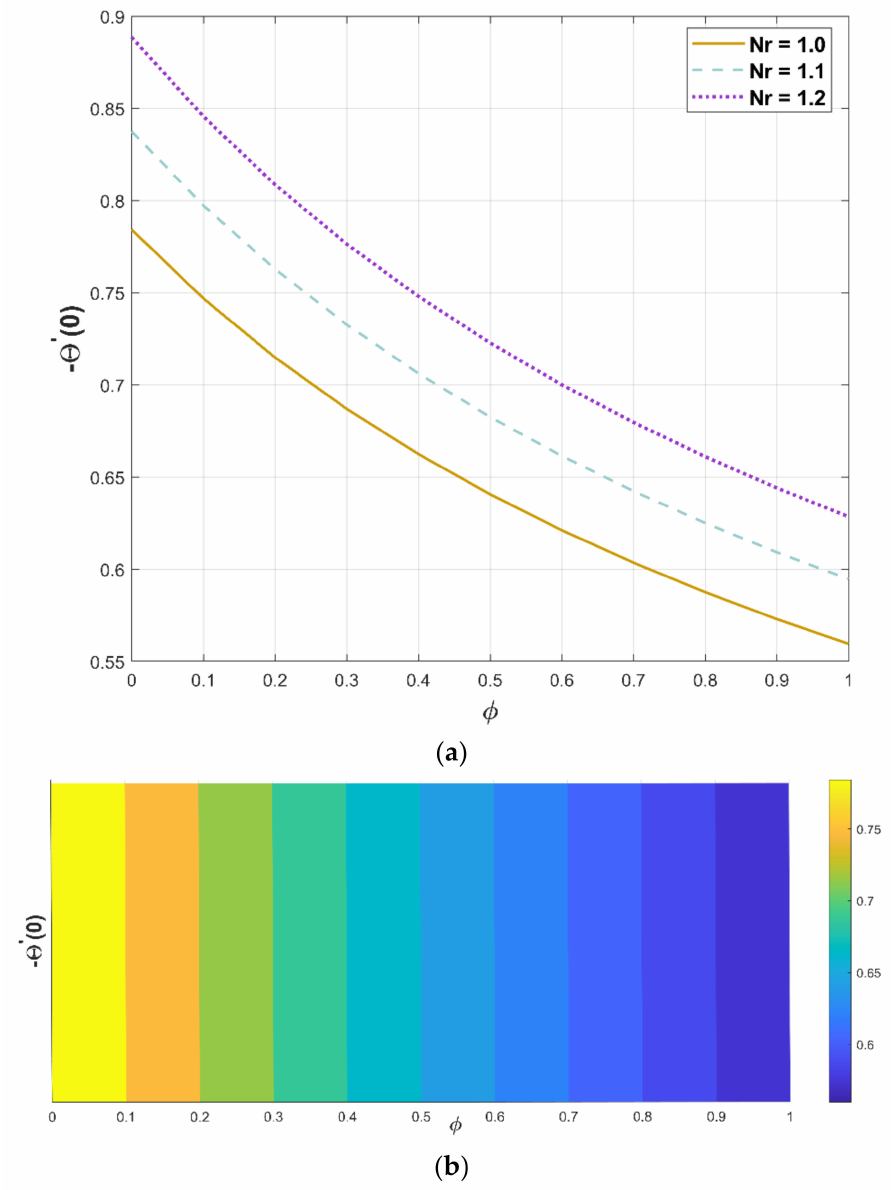
Figure 13. ( a , b ). Upshot of Nr and φ on − Θ (cid:48) ( 0 ) . For lower variability in R ∗ , it is found that the heat flux enhances. The fundamental d notion for using permeable fin is to enhance the efficacious surface area through which heat is convected to the nearby liquid. Even though the effectual thermal conductivity of the permeable fin weakens due to the discharge of solid substance, this decline is balanced by an expansion in surface area. As a consequence, increased porosities significantly augment the heat transfer rate. As predicted, improving R ∗ augments radiation heat exchange d through the porous